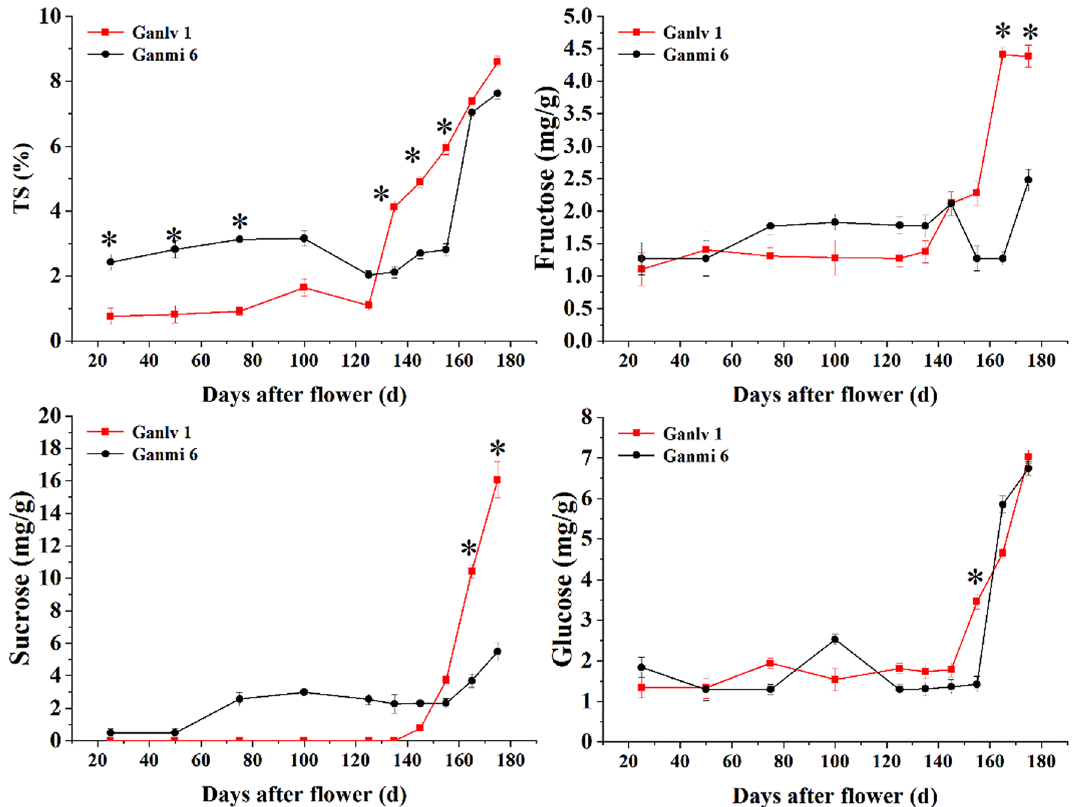
Figure 4. Changes of TS and main sugar compositions during its development.